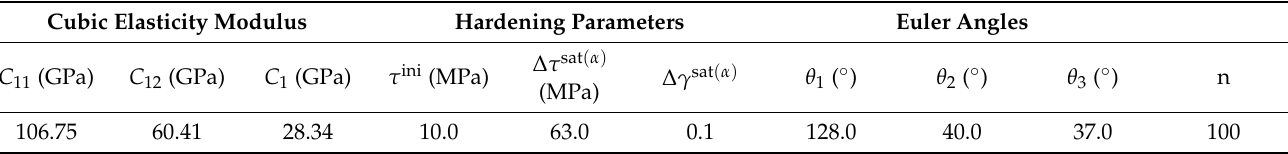
Table 1. Material parameters used in the uni-axial traction simulation with the single crystal plastic- ity